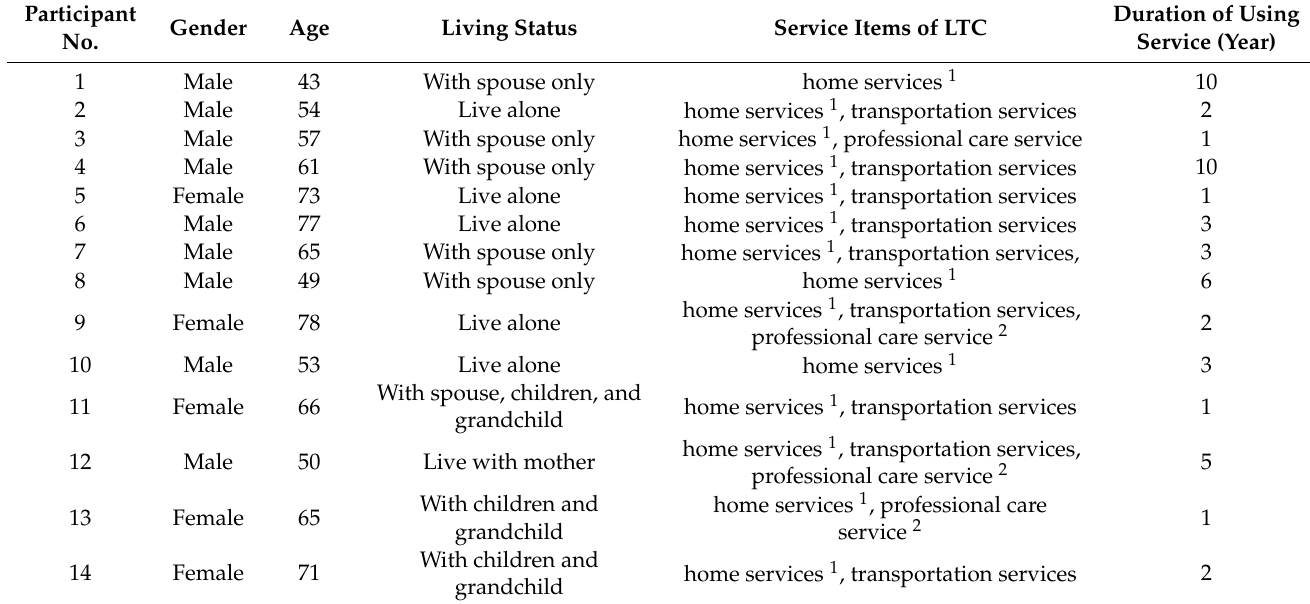
Table 1. Demographic characteristics of participants ( n = 14).